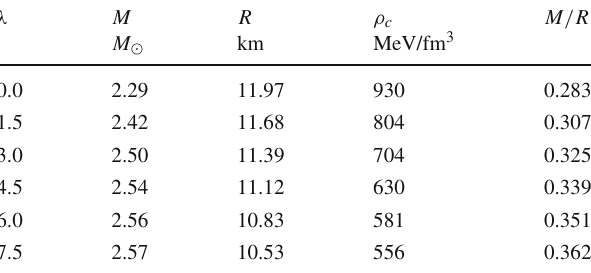
Table 1 Properties of quark stars in f ( R , T ) gravity for different val- ues of λ . Estimated values of maximum masses and their corresponding radii have been tabulated for specific central mass density ρ c . The com- pactness M / R is measured as a dimensionless quantity. Fitting param- eters for CFL EoS can reveal some features of the influence of f ( R , T ) gravity on the QSs configurations, whereas λ = 0 leading to the